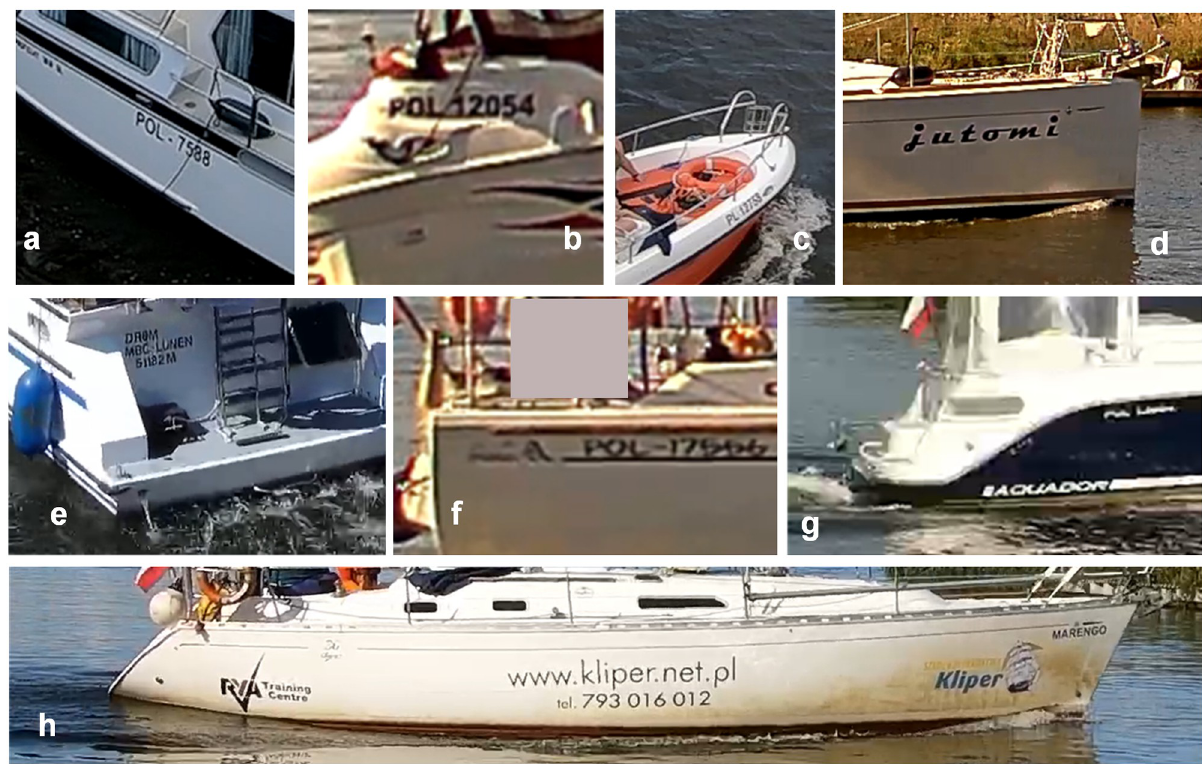
Fig 1. Examples of problematic hull inscriptions. Sample pictures taken in Szczecin Waterway Node area in Poland (own recordings).